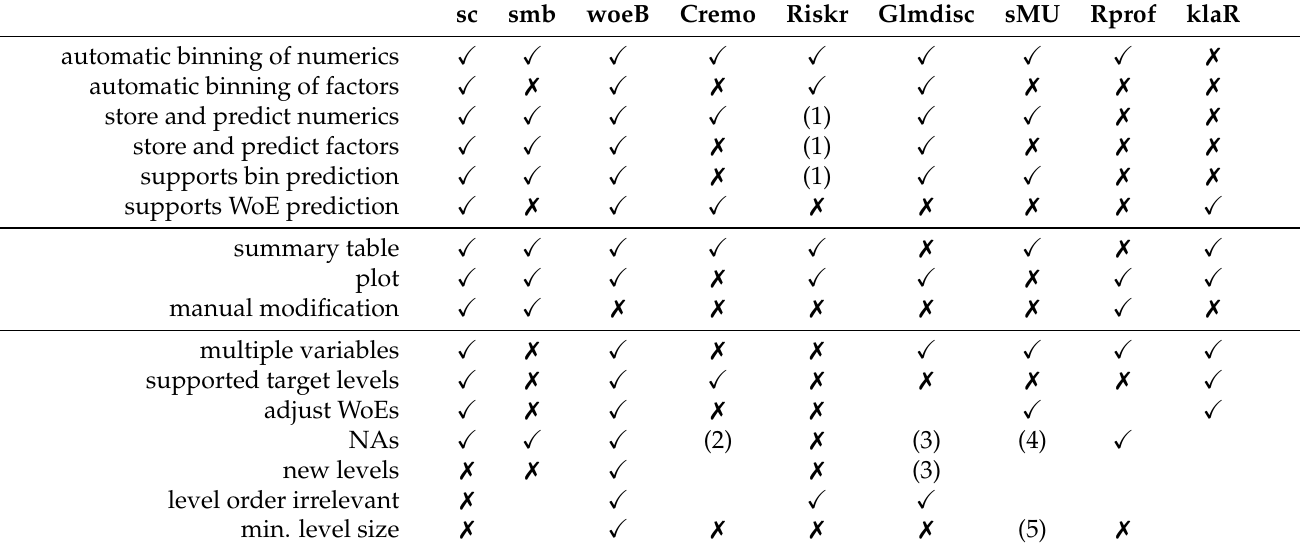
Table 3. Summary of the functionalities for binning and WoEs provided by the different packages where (cid:88) denotes available and (cid:55) not available. An empty field means that this is not relevant w.r.t. the scope of the package. (1): workaround available (cf. above); (2) separate bin ( 00.NA ) is created— binning of new data ( split_bins_all() ) possible but no WoE assignment ( (woe_trans_all) ); (3) always bin 1 assigned; (4) separate function missing_val() for imputation; (5) additional function cat_to_new() merges levels smaller than threshold (cf.